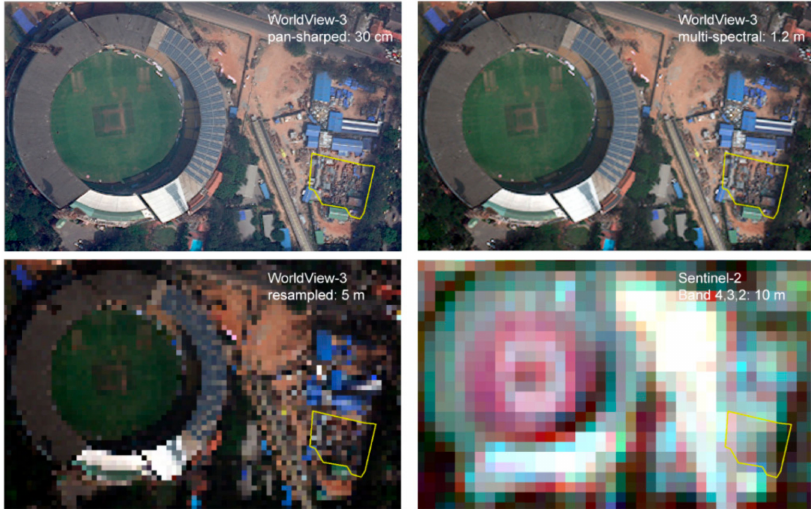
Figure 3. The ability of different sensor systems to capture a small slum pocket in Bangalore, India (image dimension: 400 × 200 m), with slum pocket in yellow (area: 2832 m 2 ) (Image sources: